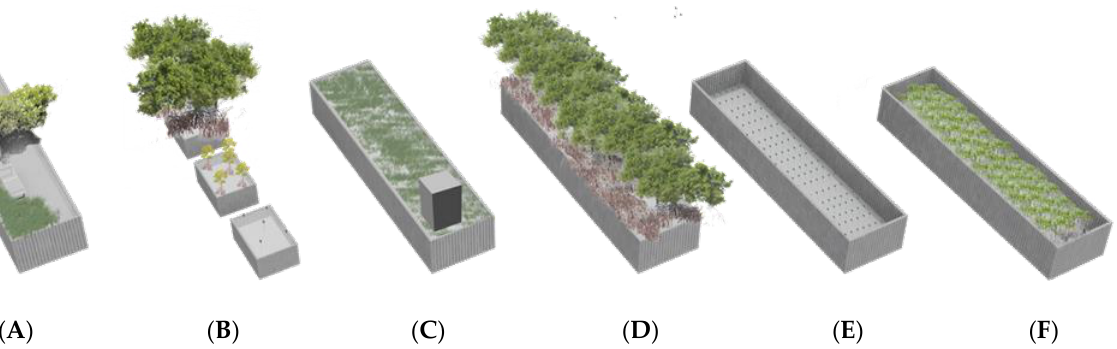
Figure A4. Design Variation of the Chinampa: ( A ). Chinampa as Public Space, ( B ). Chinampa as Restoration, ( C ). Chinampa as Sanitation, ( D ). Chinampa as Mangrove Islands, ( E ). Chinampa as Nurseries, ( F ). Chinampa as Aquaculture. © Shuwen Ye and Aubrey Jahelka.